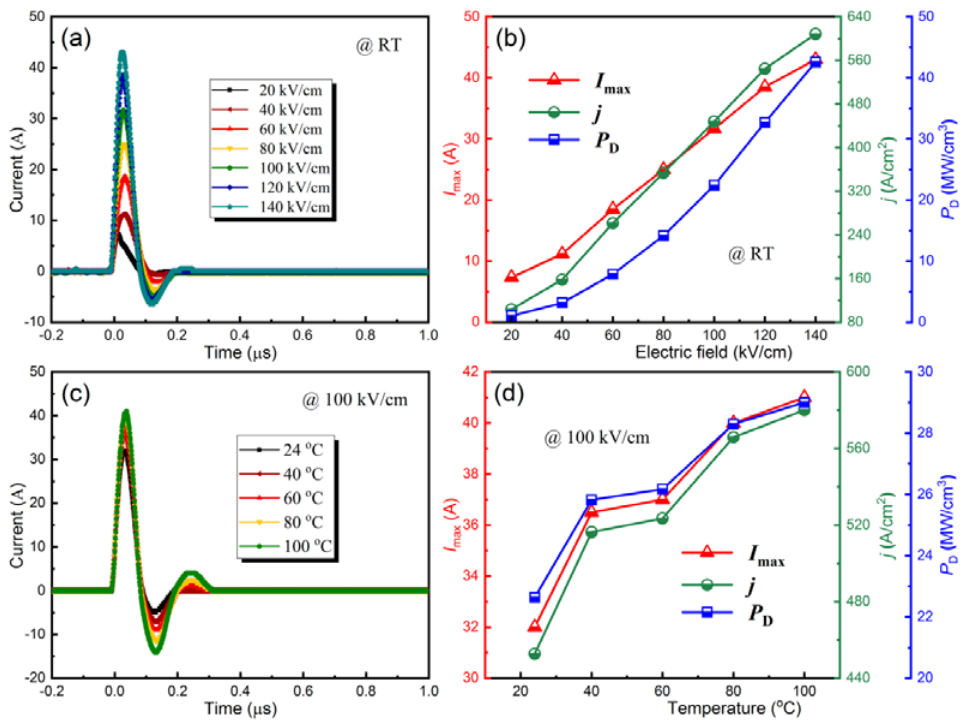
Fig. 11 (a) Underdamped discharge curves and (b) values of I , j , and P D of BS 0.5 BNT–14GS ceramic composite under different electric fields at room temperature; (c) underdamped discharge curves and (d) values of I , j , and P D of BS 0.5 BNT–14GS ceramic composite under different temperatures at 100 kV/cm.